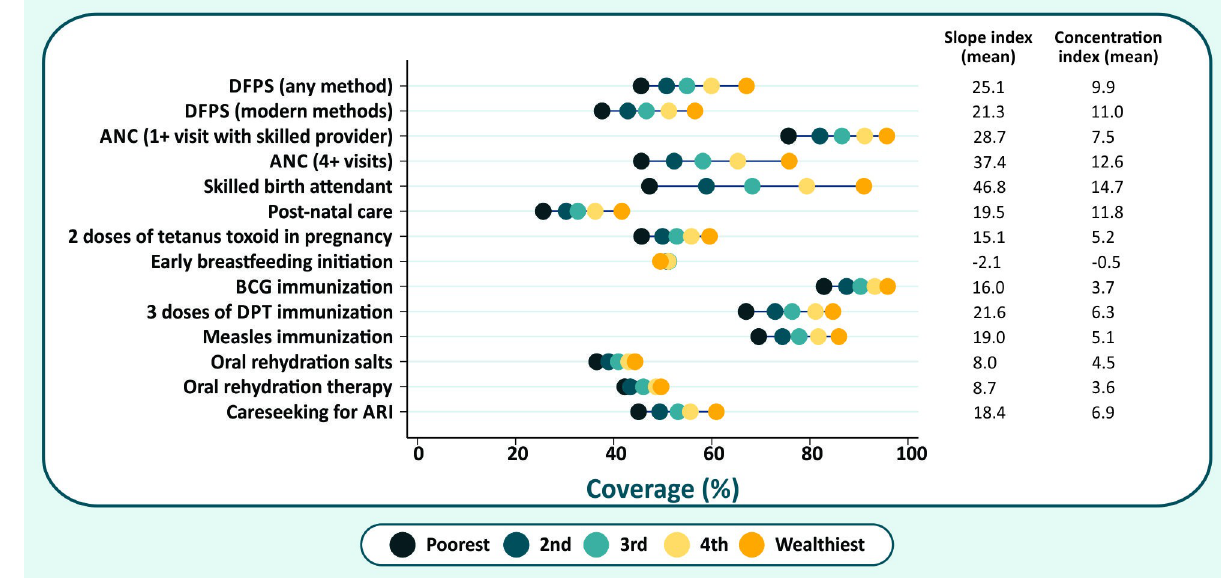
Fig 1. Average coverage levels by wealth quintile of each intervention included in the different CCI